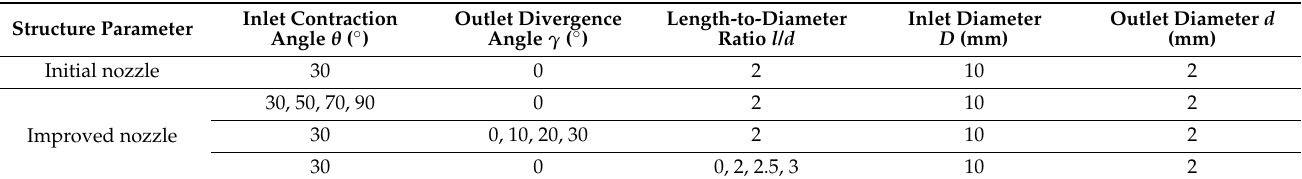
Table 1. Structure parameter of the